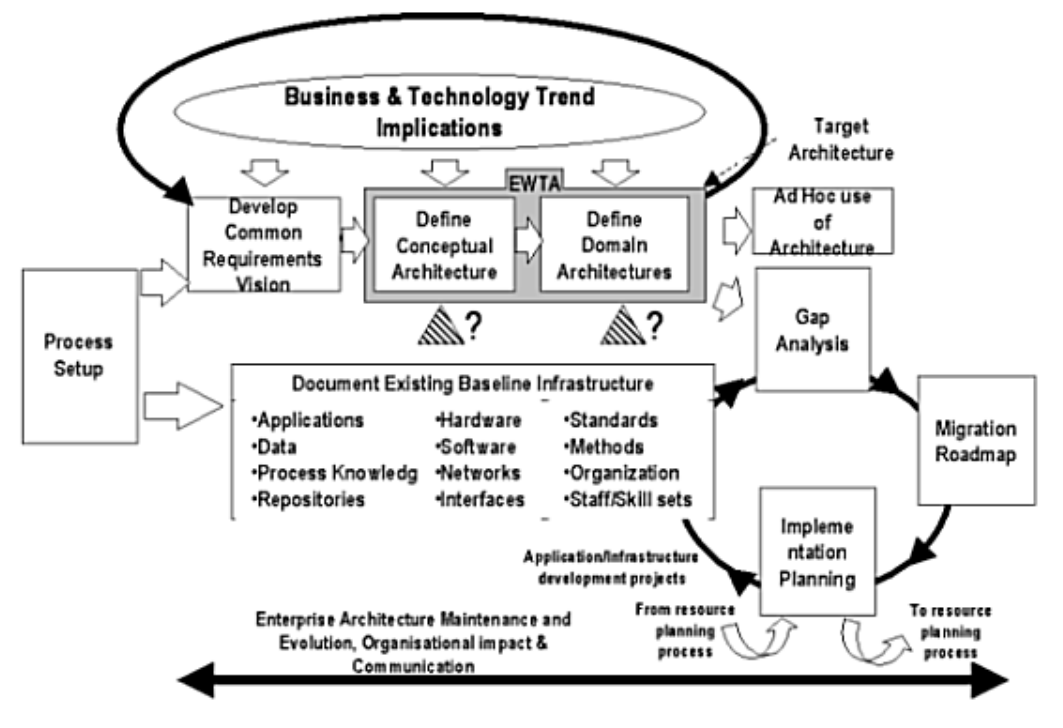
Figure 2 META Group: EAS Process Model: Evolution,